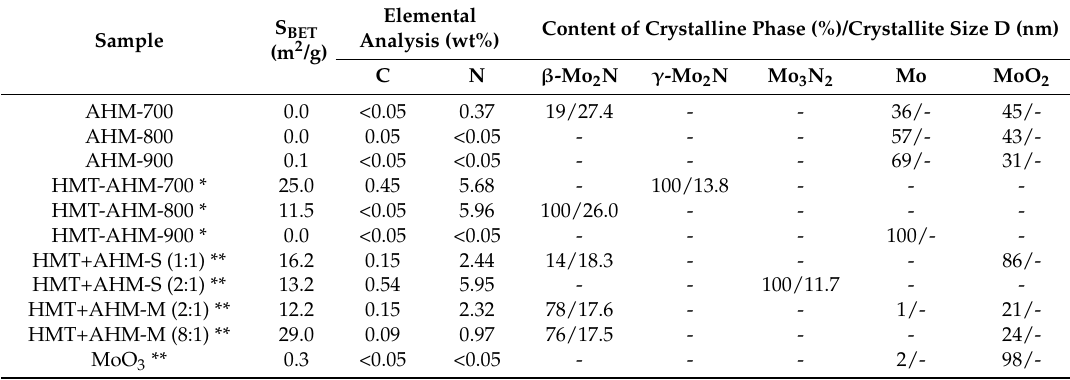
Table 2. Physicochemical properties of the prepared molybdenum